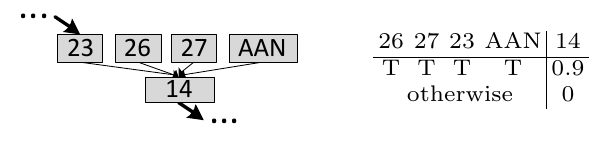
Figure 6. A Portion of Bayesian Network with AAN